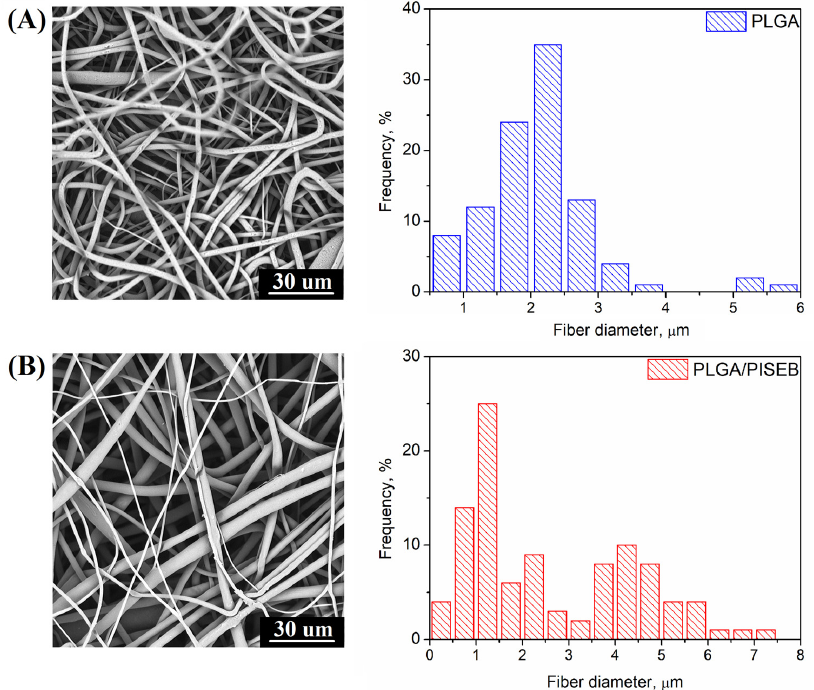
Figure 2. SEM micrographs and histograms presenting the diameter of fibers of electrospun PLGA ( A ) and PLGA/PISEB ( B ).